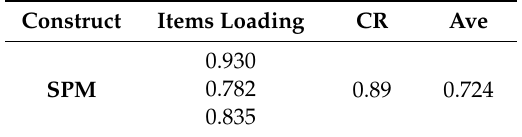
Table 8. Reliability and validity assessment for second order